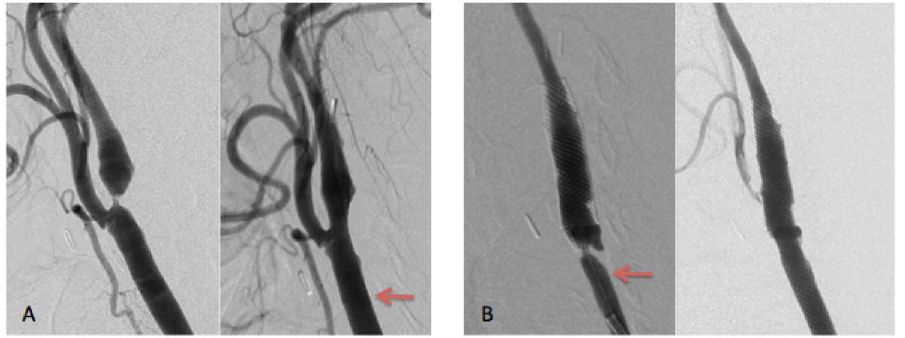
Fig 4. in-stentrestenosis: restenosis on CCA aftershortening of the carotidwall stent. A: CAROTID WALLSTENT 7–40 for a restenosispost CEA. B: shorteningof the stent and earlyin-stentrestenosis on CCA. The arrow is on the initialstent positioning.